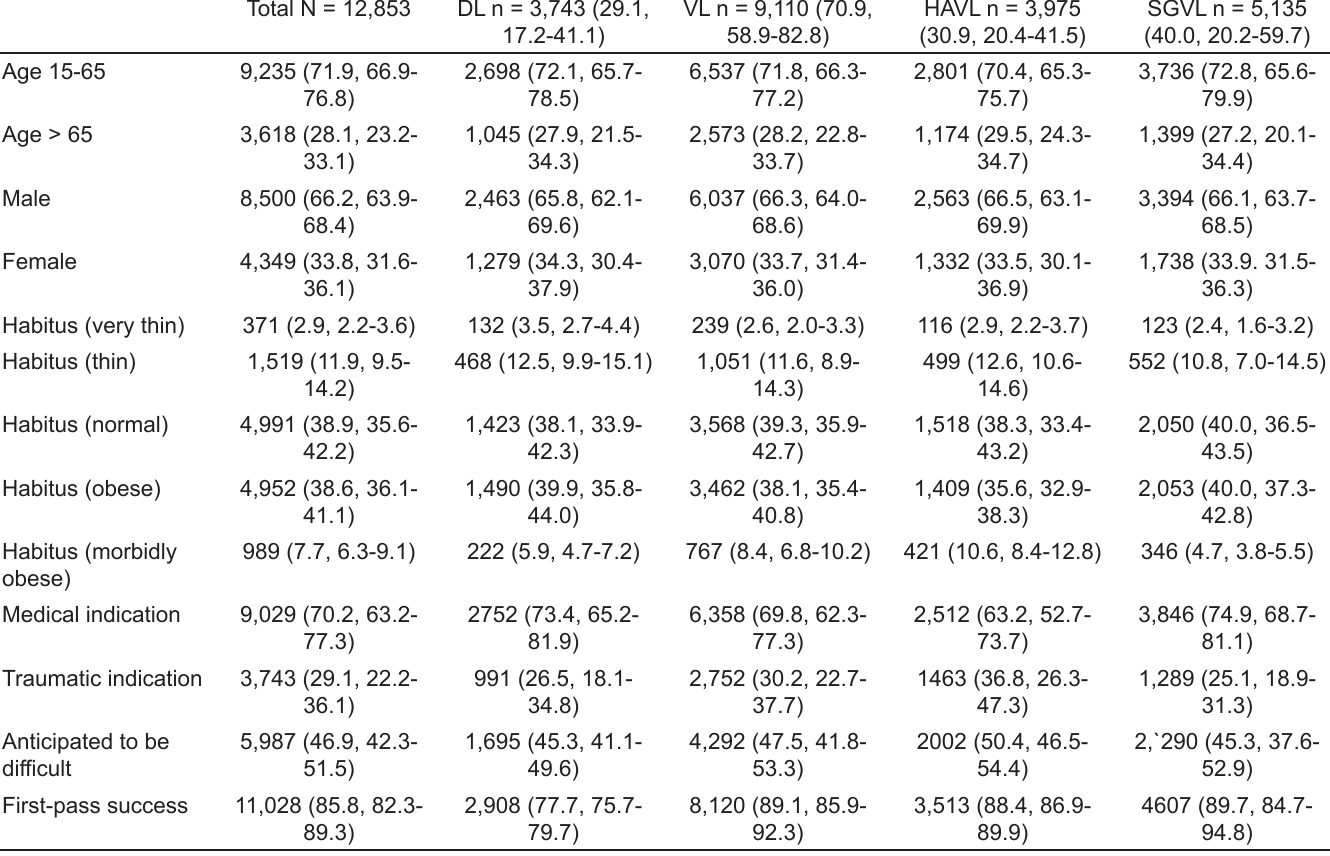
Table 1. Patient characteristics and use of DL, VL, HAVL, and SGVL* for first-pass intubation attempts among those with difficult airway